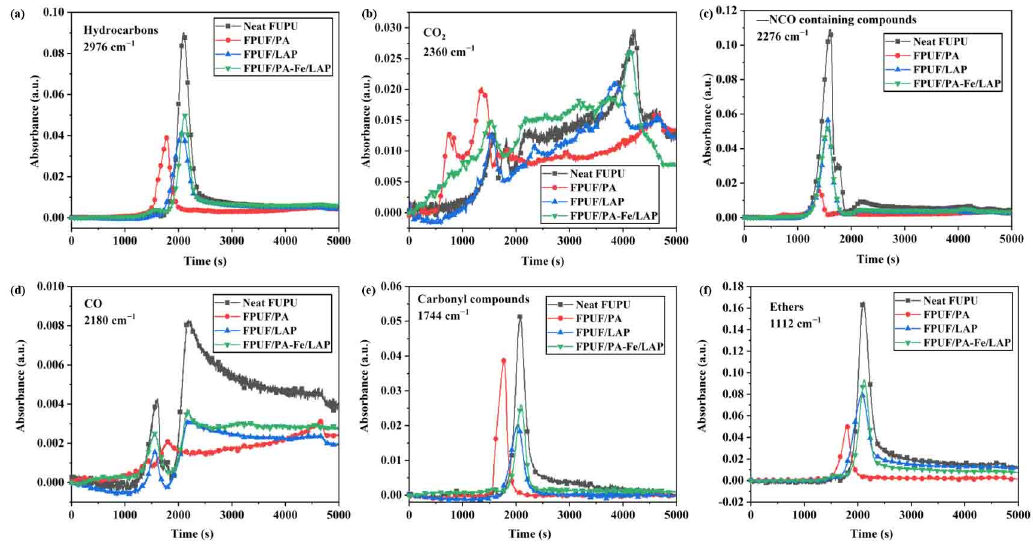
Figure 4. Absorbance intensities of Hydrocarbons ( a ), CO 2 ( b ), -NCO ( c ), CO ( d ), Carbonyl com- pounds ( e ) and Ethers ( f ) from neat FPUF, FPUF/PA, FPUF/LAP, and FPUF/PA-Fe/LAP. pounds ( e ) and Ethers ( f ) from neat FPUF, FPUF/PA, FPUF/LAP, and